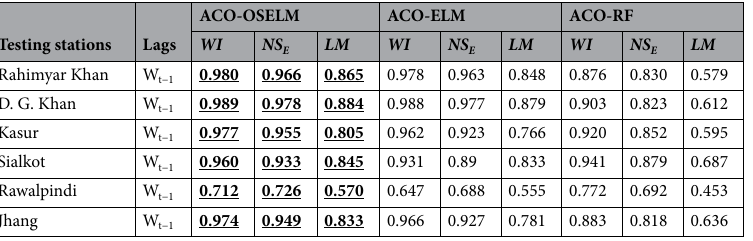
Table 7. The performance of ACO-OSELM versus ACO-ELM and ACO-RF models using Willmott’s index ( WI ), Nash–Sutcliffe ( NS E ) and Legates–McCabe’s ( LM ) agreement, for Station 1: Rahimyar Khan, Station 2: D. G. Khan, Station 3: Kasur, Station 4: Sialkot, Station 5: Rawalpindi and Station 6: Jhang. Note that the best model is boldfaced (underline).